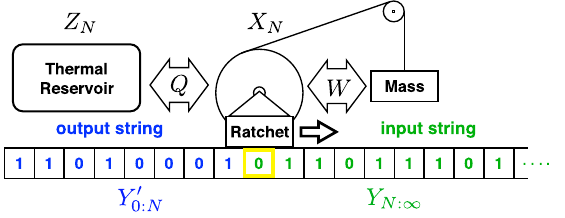
FIG. 3. Information ratchet consists of three interacting reservoirs — work, heat, and information. The work reservoir is depicted as gravitational mass suspended by a pulley. The thermal reservoir keeps the entire system thermalized to temperature T . At time N τ , the information reservoir consists of (i) a string of … , each cell storing an Y 0 0 Y 0 1 … Y 0 Y Y symbols Y N ¼ N N þ 1 N − 1 element from the same alphabet Y , and (ii) the ratchet ’ s internal state X . The ratchet moves unidirectionally along the string, N exchanging energy between the heat and the work reservoirs. The ratchet reads the value of a single cell (highlighted in yellow) at a given time from the input string (green, right); interacts with it; and writes a symbol to the cell in the output string (blue, left) of the information reservoir. Overall, the ratchet transduces the input string Y 0 ∶∞ ¼ Y 0 Y 1 … into an output string Y 0 0 ∶∞ ¼ Y 0 0 Y 0 1 … . (Reprinted from Ref. [21] with